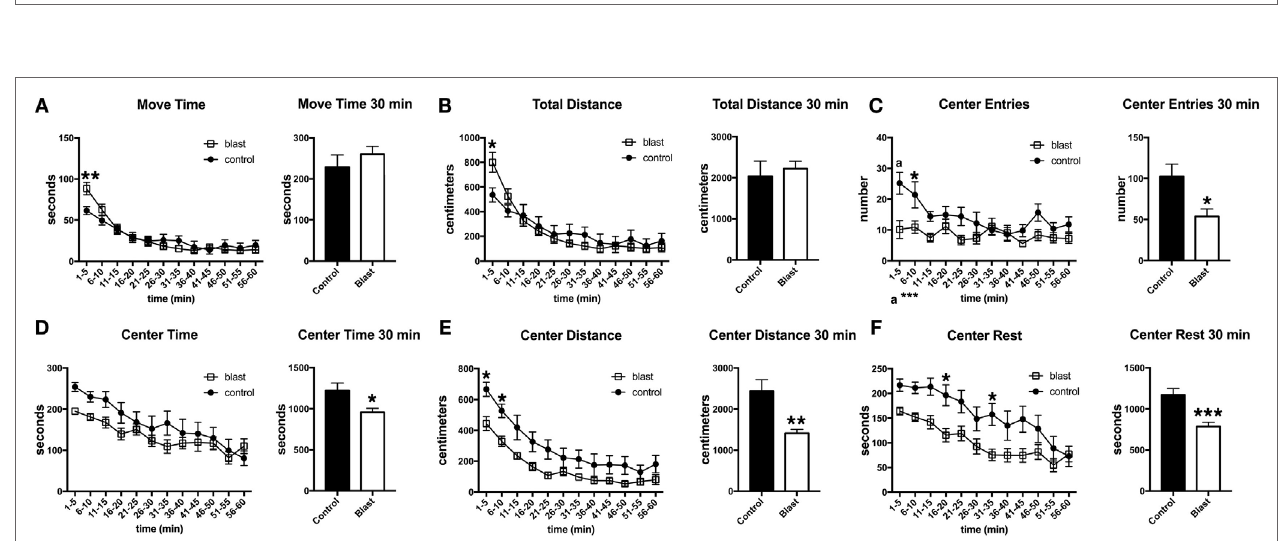
FigUre 4 | Behavioral changes are still present 45 days following a predator scent exposure . Activity of blast and control rats was assessed in an open field for 60 min at 45 days after the predator scent exposure. Shown are time in motion (a) , total distance moved (B) , center entries (c) , center time (D) , distance traveled in the center (e) , and center rest time (F) . Error bars indicate ± SEM. Asterisk(s) indicate statistically significant differences between blast-exposed and control [* p < 0.05, ** p < 0.01, *** p < 0.001, a in (c) indicates p < 0.001, all comparisons unpaired t -tests].